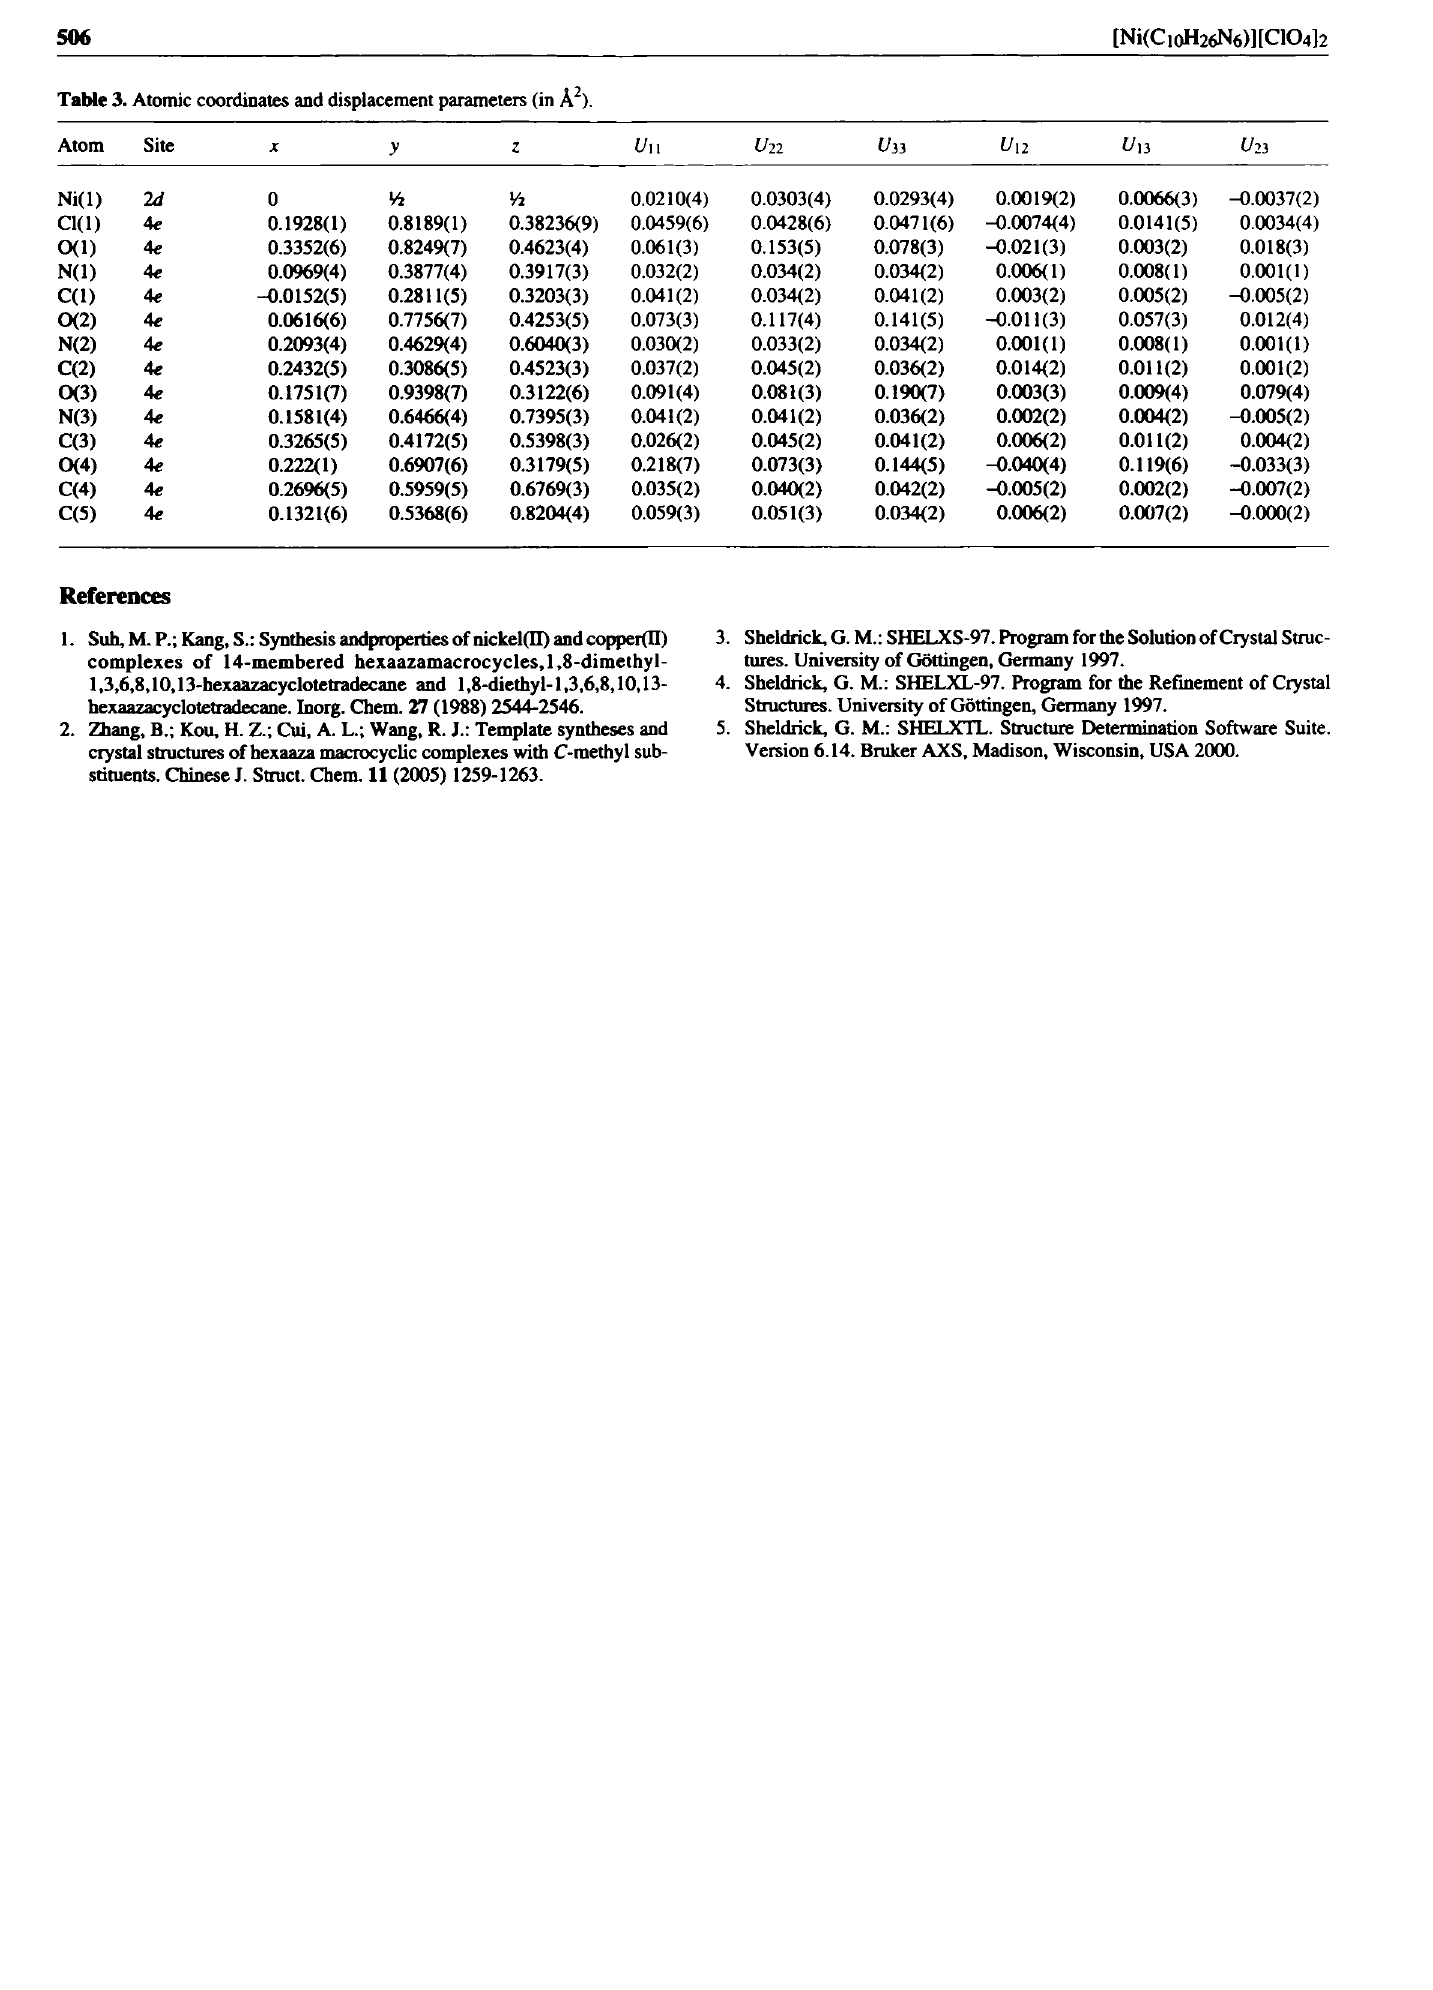
Table 3. Atomic coordinates and displacement parameters (in Ä 2